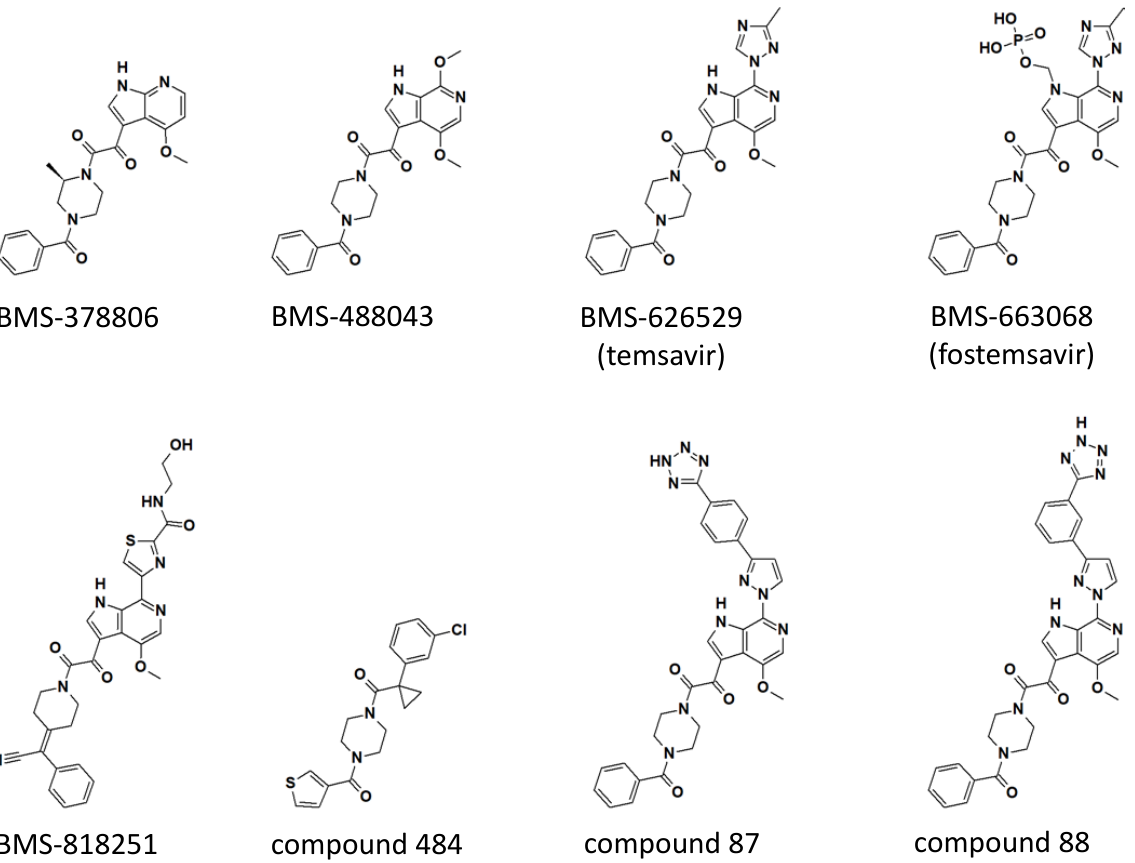
Figure 2. Chemical structures of temsavir and analogues. Two-dimensional chemical structures are shown for each compound. Three-dimensional structures of BMS-378806, BMS-626529 (temsavir), BMS-818251, and compound 484 in complex with HIV-1 envelope protein have been determined (see Figure 3). Compounds 87 and 88 were based on the numbering from reference [32]. Computational models of compounds 87 and 88 in complex with HIV-1 Env are also available in reference